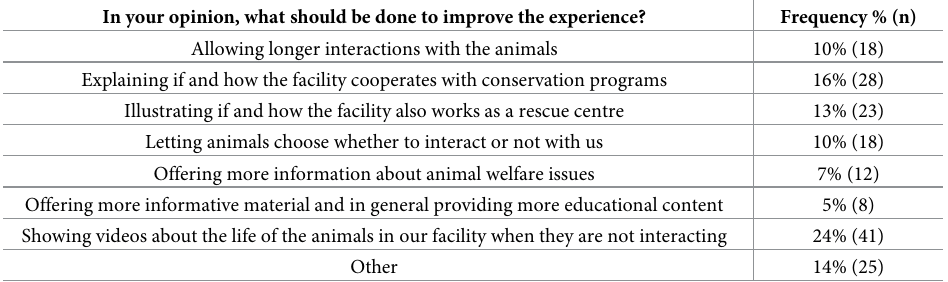
Table 5. Distribution of answers to question n.